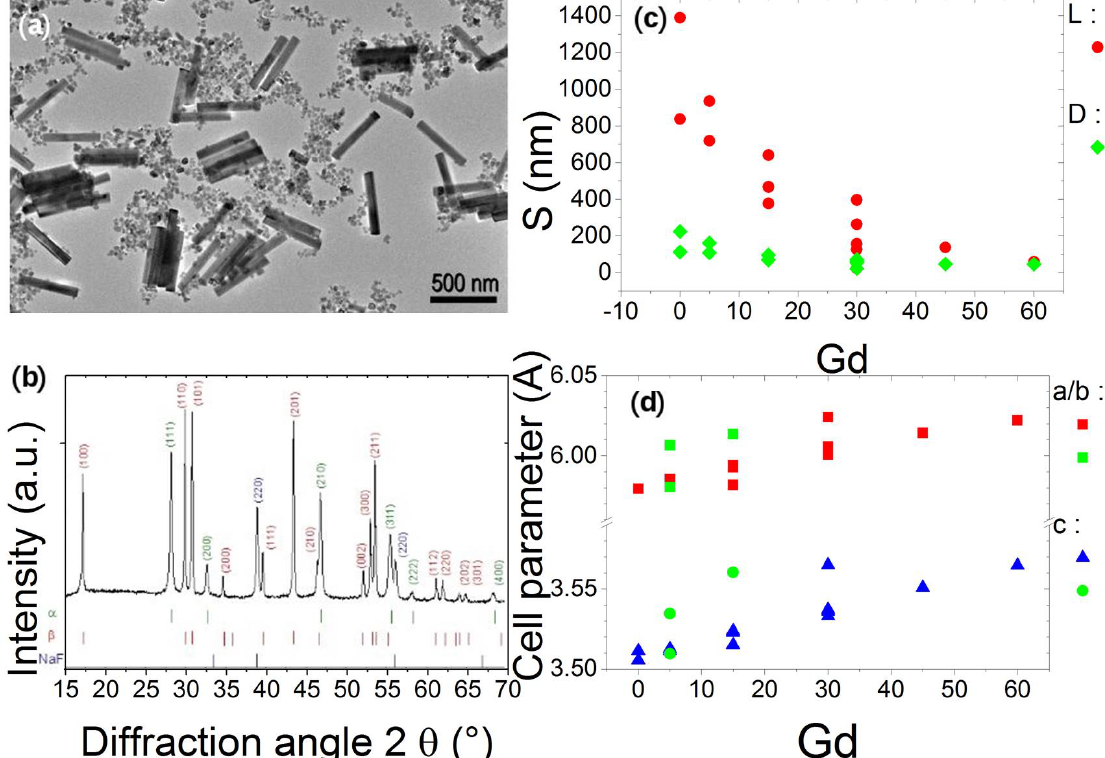
Figure 4. NaYF 4 nanoparticles ( a ) Transmission Electron Microscopy (TEM) image with small cubes ( α -NaYF 4 ) big nanorods ( β -NaYF 4 ) NR01 ( b ) typical X-ray pattern of these particles ( c ) TEM NPs sizes S (L = lenght, D = diameter) and ( d ) cell parameter dependences vs Gd nominal doping with blue triangles and red squares for the main set of cell parameters of each batch and green squares and green circles for the second set of cell